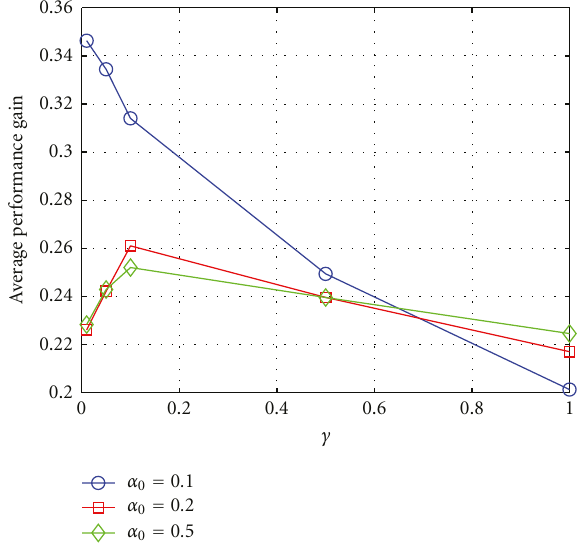
Figure 11: CDF of learning delay with di ff erent learning factor α 0 when N = 2 and system state is fully observable.